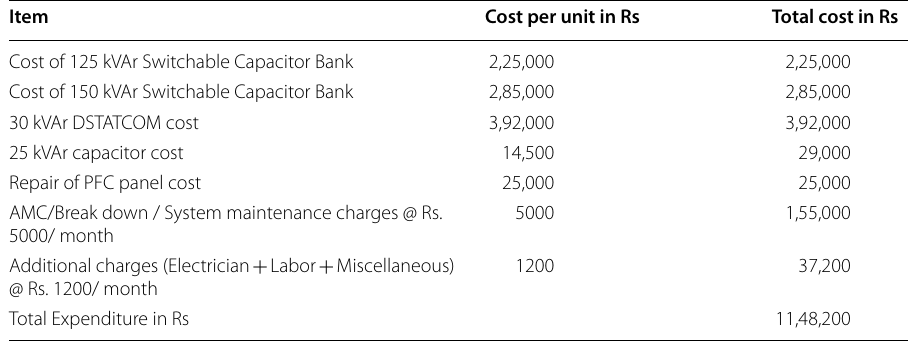
Table 5 Investment cost details of SUES Substation with power factor correction